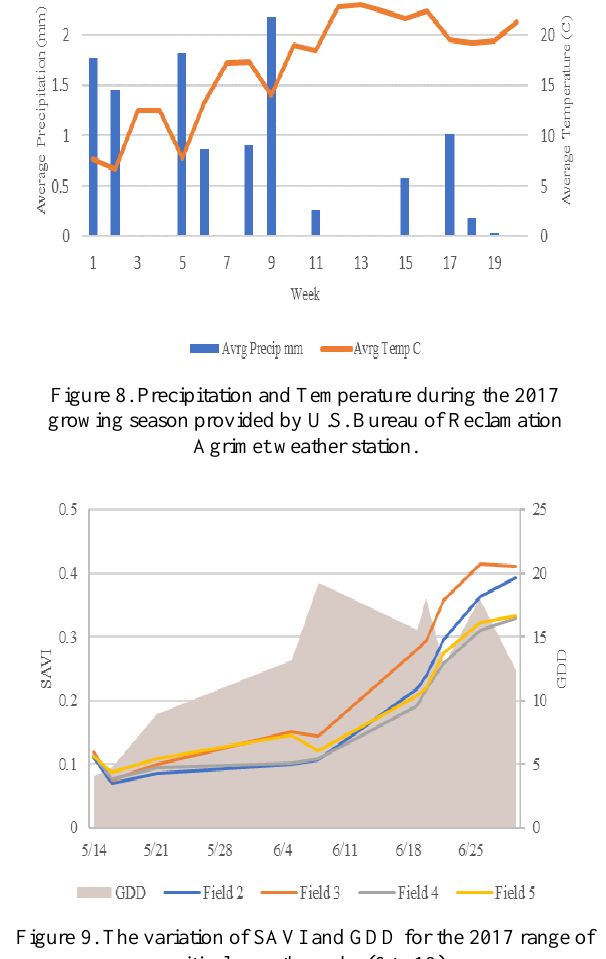
Figure 10. Predicted yield values in kg/1000m 2 (A) and the corresponding slope values in degrees